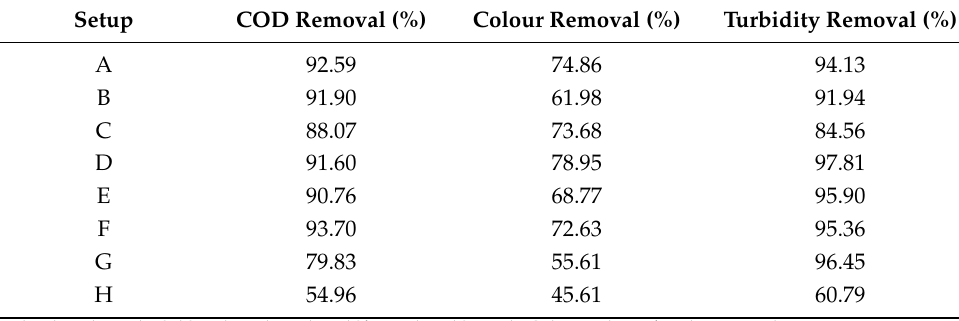
Table 3. The water quality analysis for BS